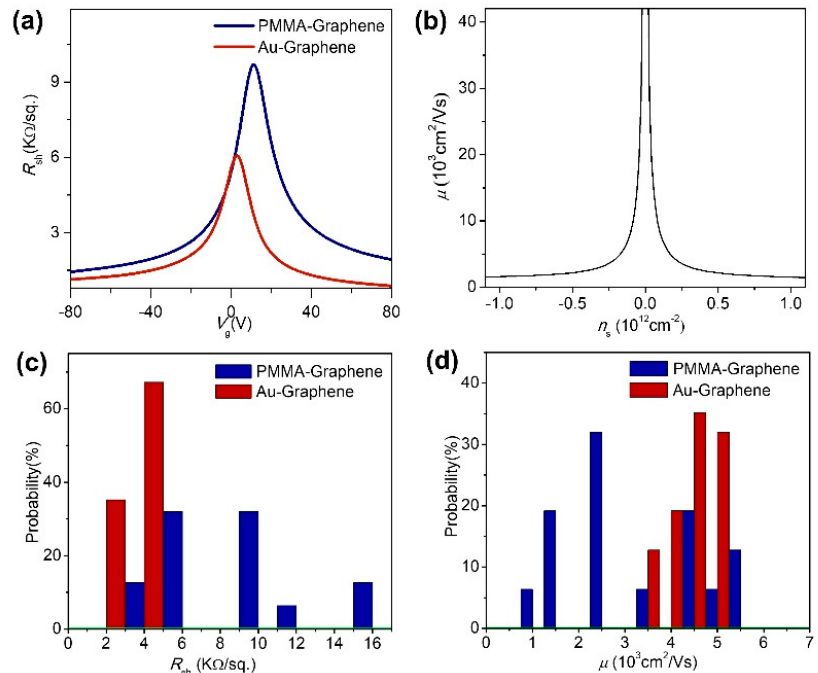
Figure 3. ( a ) Gate voltage ( V g ) vs. sheet resistance ( R sh ) curves at GFETs with a Hall-bar structure, ( b ) A calculated carrier density ( n s ) vs. carrier mobility ( μ ) curve of the GFET fabricated by Au- assisted transfer method, ( c ) The distribution of measured sheet resistance at V dirac and ( d ) The distribution graph of mobility at n s = 3 × 10 11 cm − 2 .